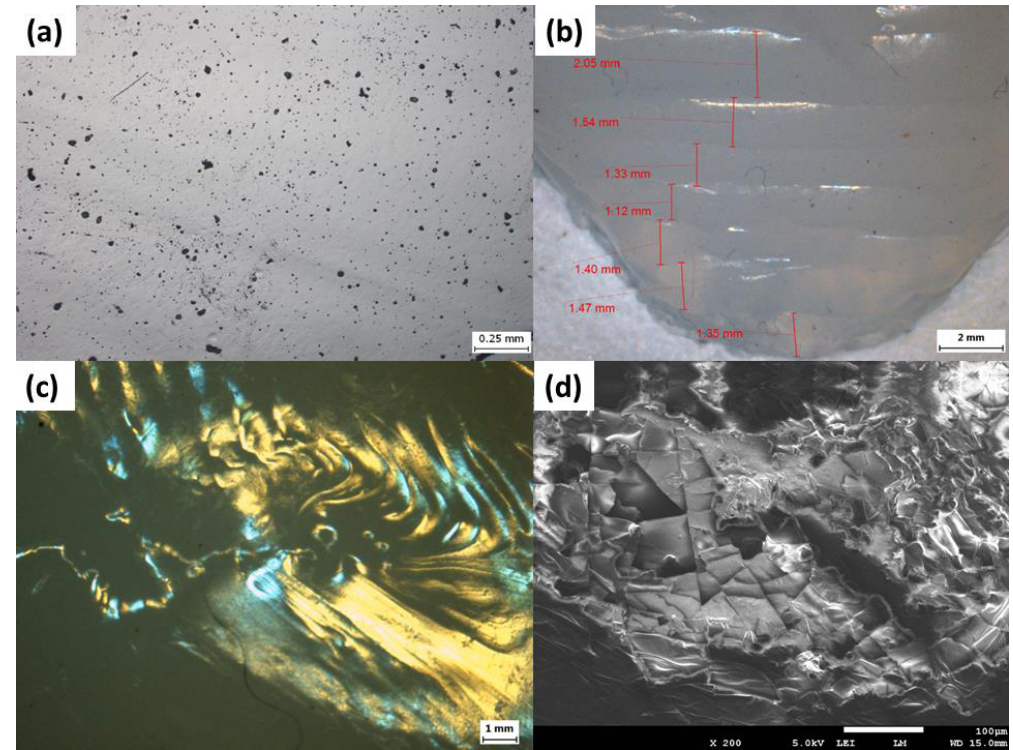
Figure 12. Bright field images of ( a ) surface, ( b ) posterior horn and ( c ) anterior horn of 3D printed silicone meniscus implant. ( d ) Scanning electron microscopy (SEM) image of meniscus surface at ×200 magnification.